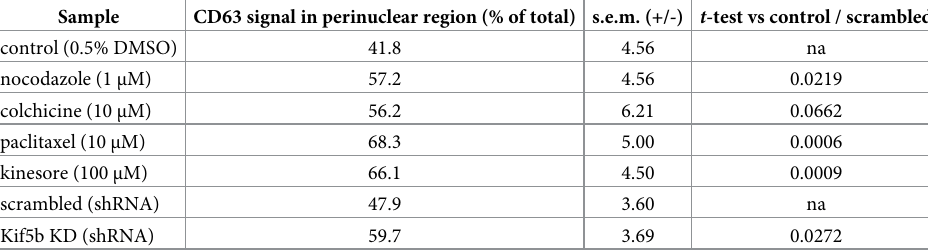
Table 2. Quantification of perinuclear-retained CD63 signal in antigen-stimulated RBL-2H3 cells.